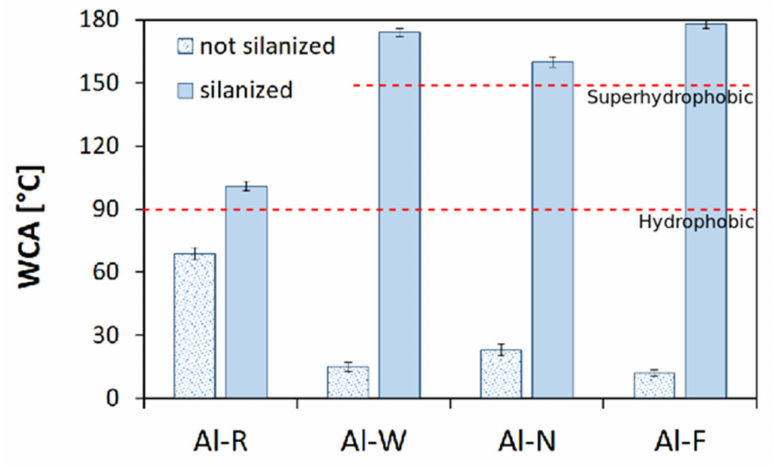
Figure 6. Water contact angles of silanized and not silanized aluminum before and after surface